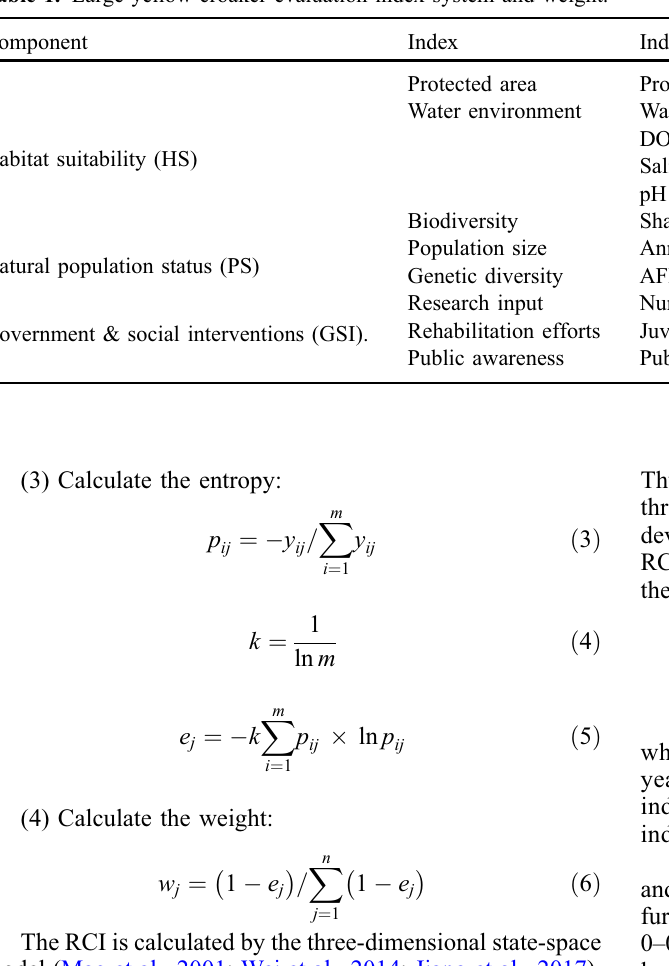
Table 1. Large yellow croaker evaluation index system and weight.